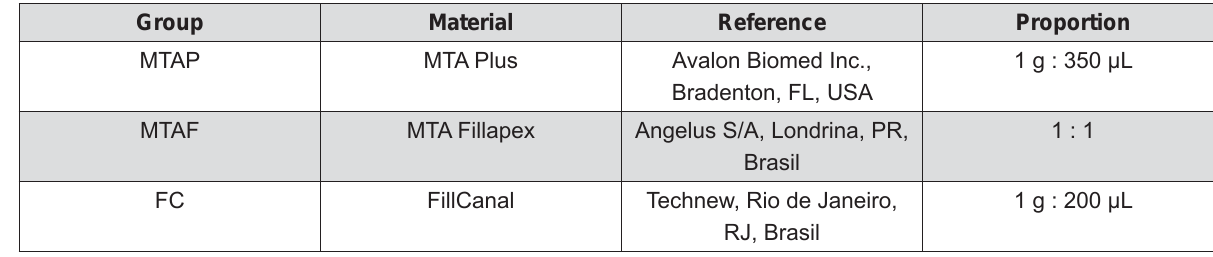
Figure 1- Endodontic sealers